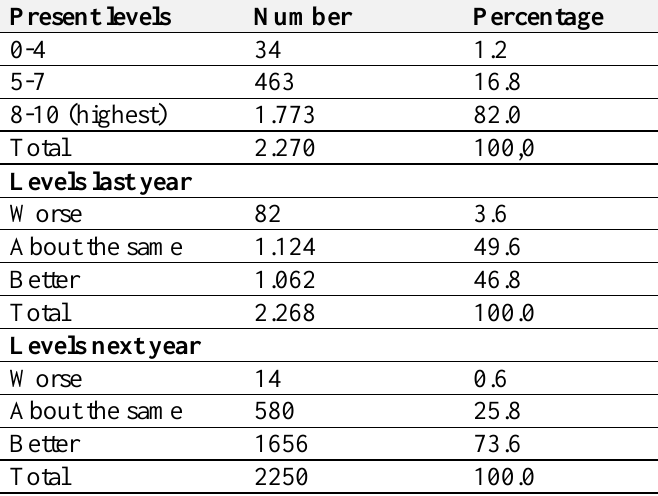
Table 3. Frequency distribution of life satisfaction